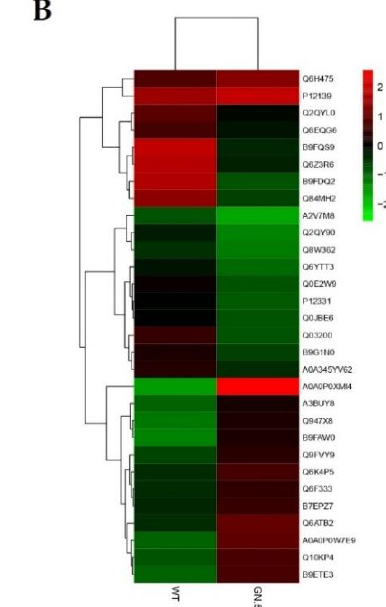
Figure 3. Identified proteins and heatmap of wild type and CRISPR mutant line (GN-5). ( A ) The number of the total, and differentially expressed proteins (up and down-regulated). ( B ) Proteins with higher expression difference among WT and mutant. Red color denotes higher while the green color is representing the lower level of expression.